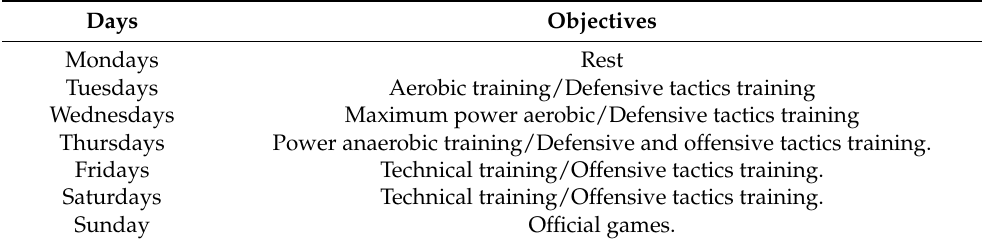
Table 1. Details of the weekly training routine of participants performed by both control and experimental groups over the 8-week